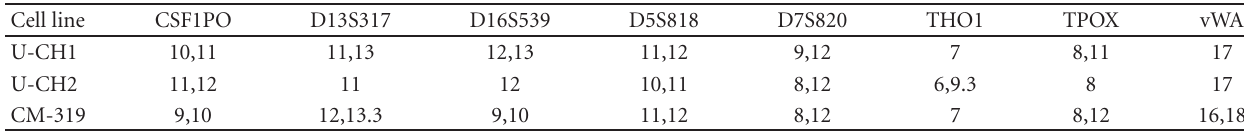
Table 3: STR Genotype of Three Putative Chordoma Cell